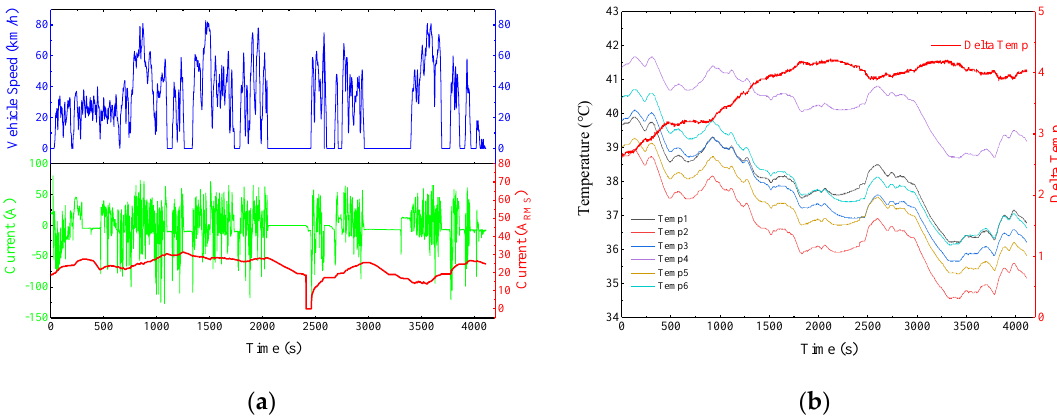
Figure 16. Test conditions and test results of the temperature on vehicles: ( a ) road spectrum, transient current spectrum, and RMS current over ten minutes; ( b ) ambient temperature inside the battery pack temperature trends from six sensors, and temperature difference curves.